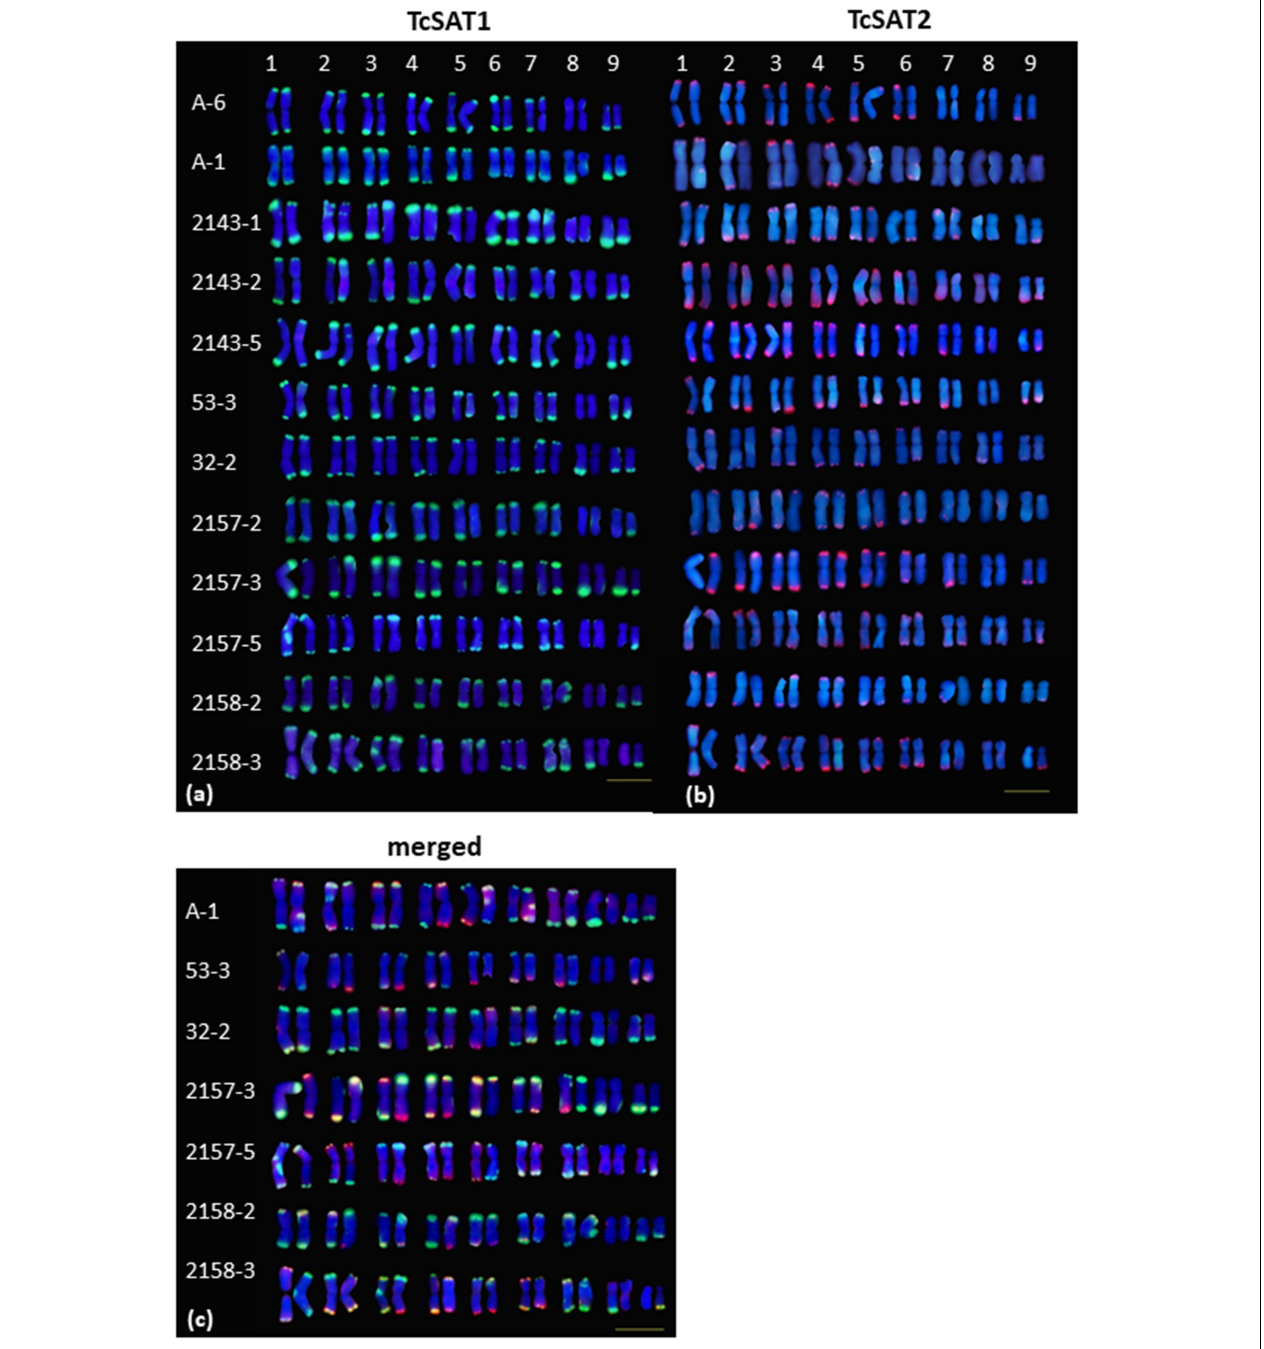
FIGURE 3 | Polymorphism of the TcSAT1 (green) and TcSAT2 (red) sites revealed by FISH. Homologous chromosome pairs were identified based on the morphology and FISH signal patterns and arranged according to their sizes. Accession number is left to the kariograms. Scale bar, 10 µ m.